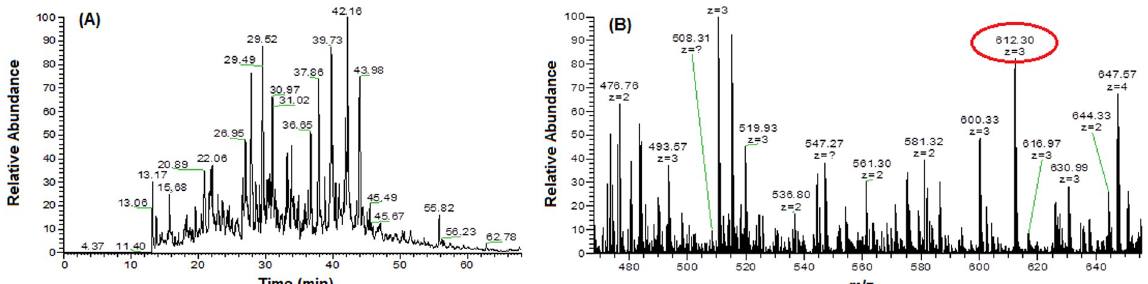
Fig 2. (A) Base peak chromatogram of tissue sample on Orbitrap LTQ-LC/MS–CID activation. (B) Expanded region of a single FTMS full scan, with a mass range of m/z 400–1800, and ion peaks with double or higher charge (612.30, z = 3).